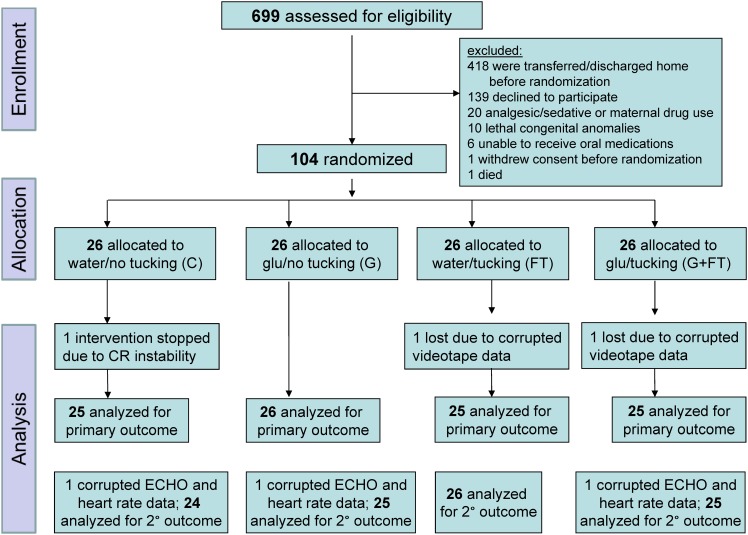
Study flow diagram.